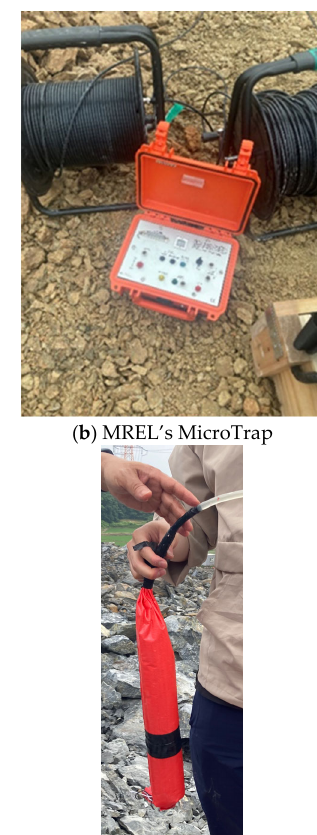
Figure 8. Schematic of the blast hole measurement system.